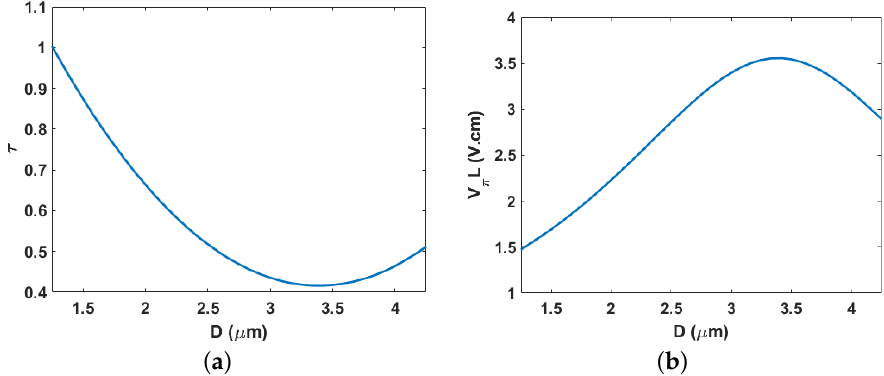
Figure 3. ( a ) τ and ( b ) V π L for varying rib placement for w c = 8.25 µ m and w g = 5.75 µ